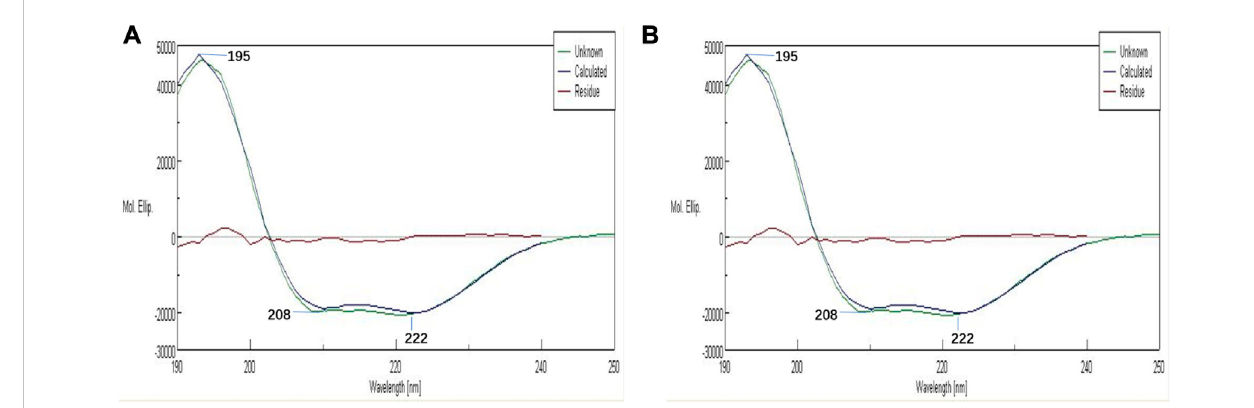
FIGURE 1 CDs of PolyCHb before (A) and after (B) AA addition.